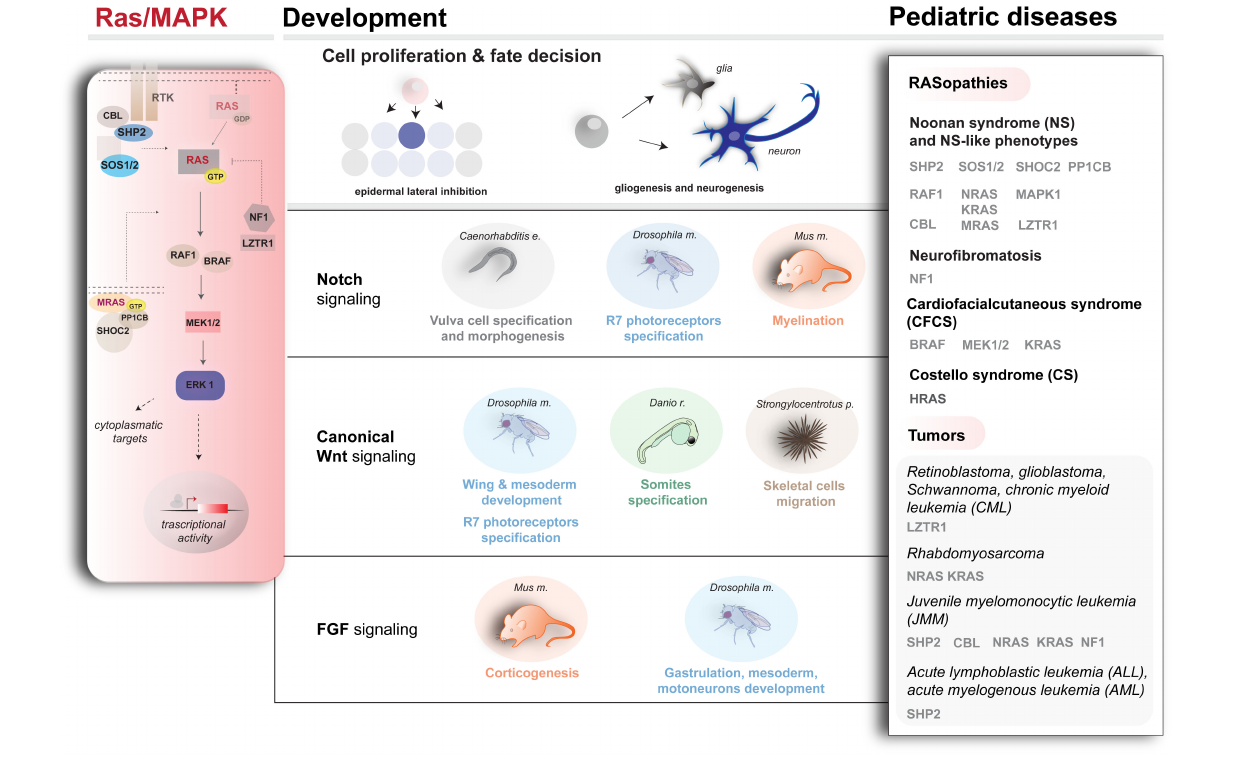
FIGURE 1 | Schematic representation of Ras/MAPK cascade (left), Ras/MAPK-influenced pathways, and developmental processes (center) and examples of genetic conditions underlying a dysregulated cascade (right). For the diseases and disease–genes depicted here, besides the literature cited in the text, refer to Roberts et al. (2007) and Tartaglia et al. (2007) ( SOS1 mutations in NS), Carta et al. (2006); Pandit et al. (2007); Cordeddu et al. (2009); Cirstea et al. (2010) ( KRAS , NRAS , RAF1 , and SHOC2 mutations in NS and related conditions), Aoki et al. (2005, 2013) ( HRAS mutations in CS), Flex et al. (2014) ( RRAS mutations in a RASopathy condition prone to cancer), Yamamoto et al. (2015) ( SOS2 , LZTR1 mutations in NS), Martinelli et al. (2010, 2015); Pérez et al., 2010 ( CBL mutations in a developmental syndrome prone to cancer), Urosevic et al. (2011); Aoidi et al. (2018) ( BRAF , MEK1 , or MEK2 mutations in CFCS), and Capri et al. (2019) ( RRAS2 mutations in